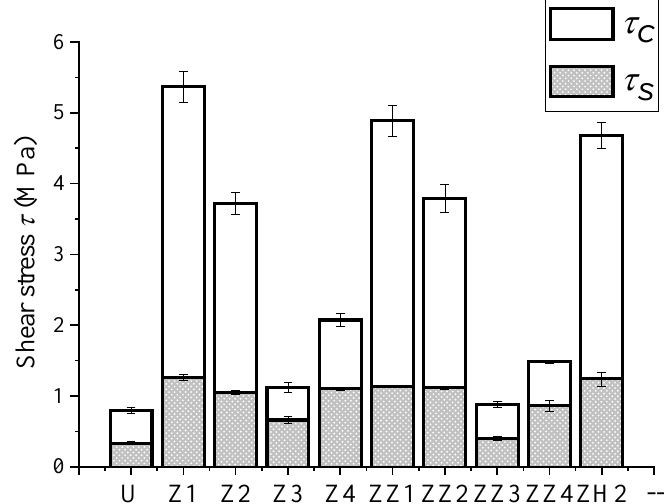
Figure 8. Bonding strengths ( τ max = τ c + τ s ).